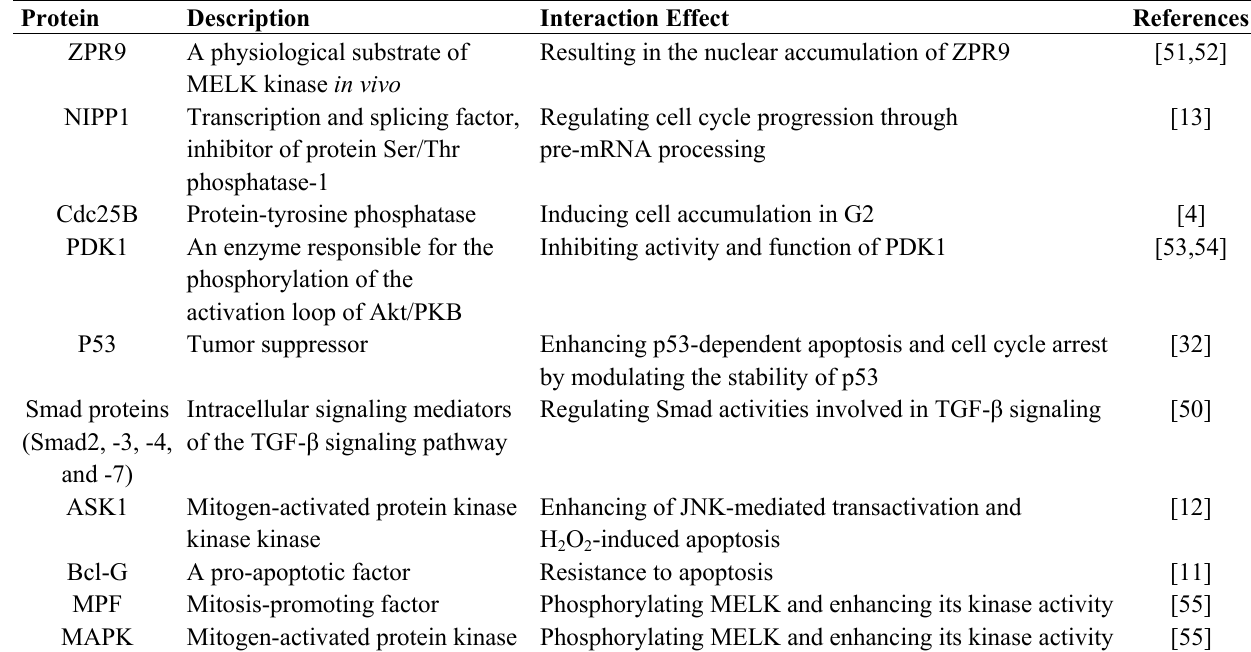
Table 2. Proteins that interact with